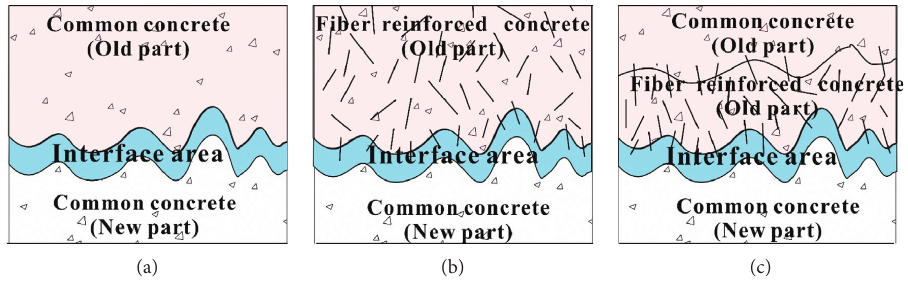
Figure 1: New-to-old